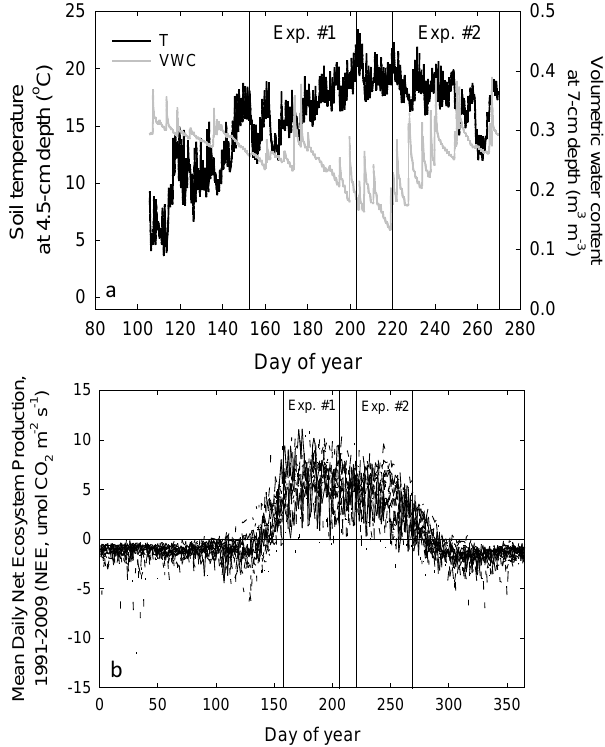
Fig. B1. Environmental attributes during field exudation treatments at Harvard Forest, MA, 2011 (a) . There were two experiments (Exp. #1 and Exp. #2), demarcated by thin vertical black lines. Both experiments lasted 50 days. Net Ecosystem Exchange (NEE) of CO 2 measured at the Environmental Measurements Site (EMS) over the period 1991–2006 showed a consistent seasonal cycle (b)